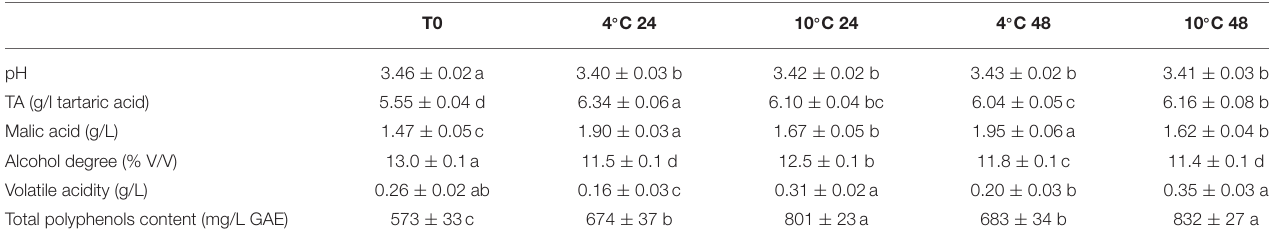
TABLE 2 | pH, titratable acidity (g/L tartaric acid), malic acid (g/L), alcohol degree (% V/V), volatile acidity (g/L), and polyphenols content (mg/L GAE) in wines at the end of the alcoholic fermentation.